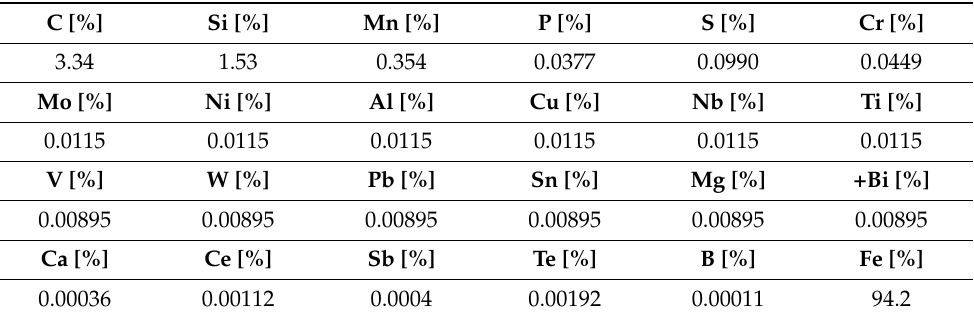
Table 5. Chemical analysis of the sample made of gray cast iron with spheroidal graphite type